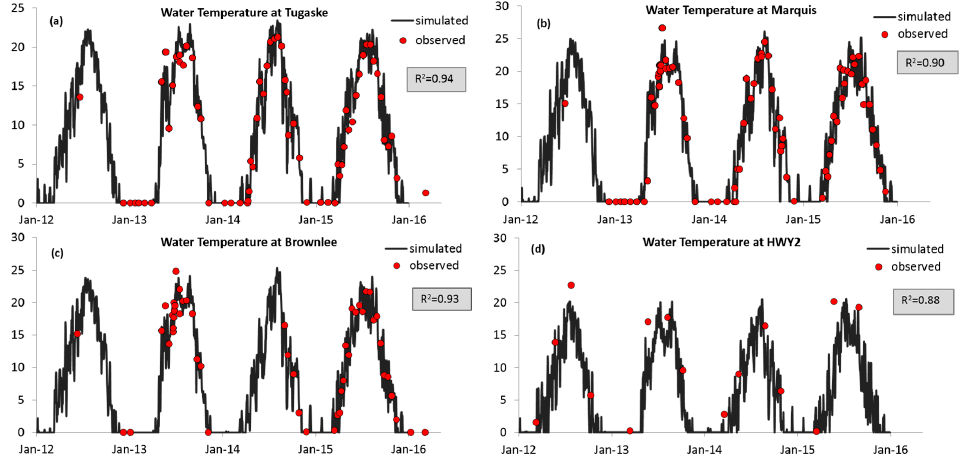
Figure 4. Simulated and measured water temperature at ( a ) Tugaske; ( b ) Marquis; ( c ) Brownlee; and ( d ) HWY#2.